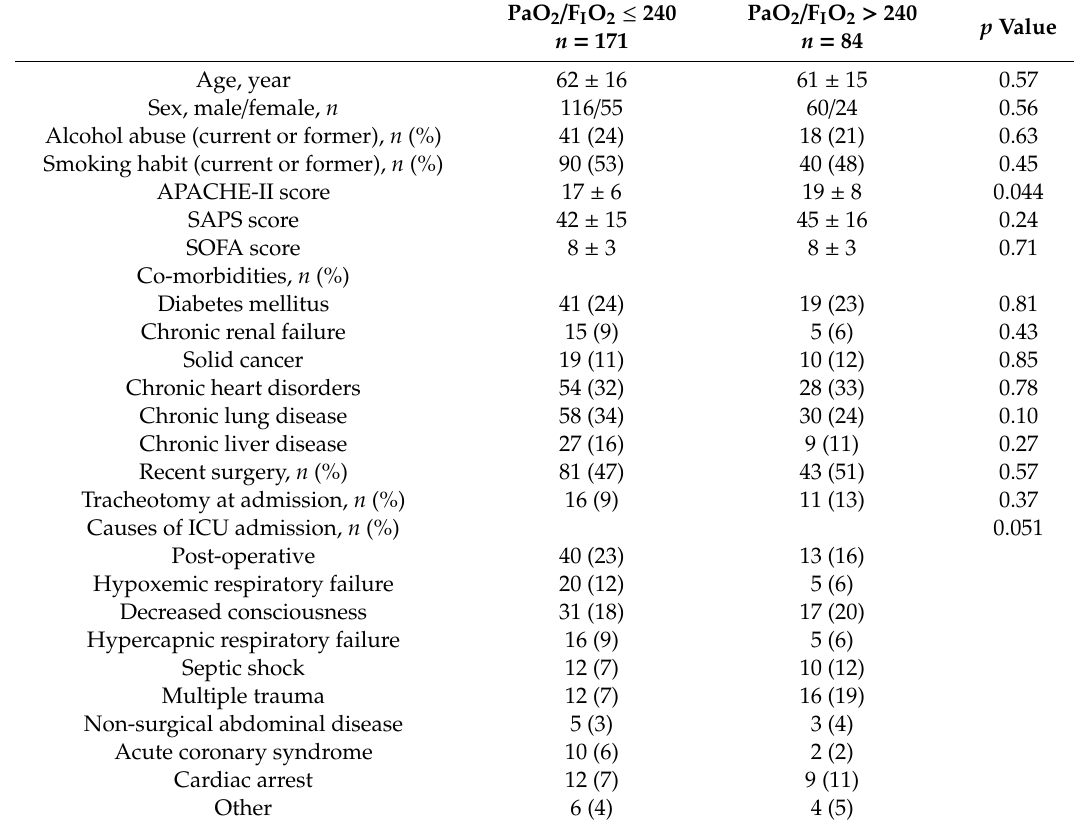
Table 1. Baseline characteristics of patients at ICU